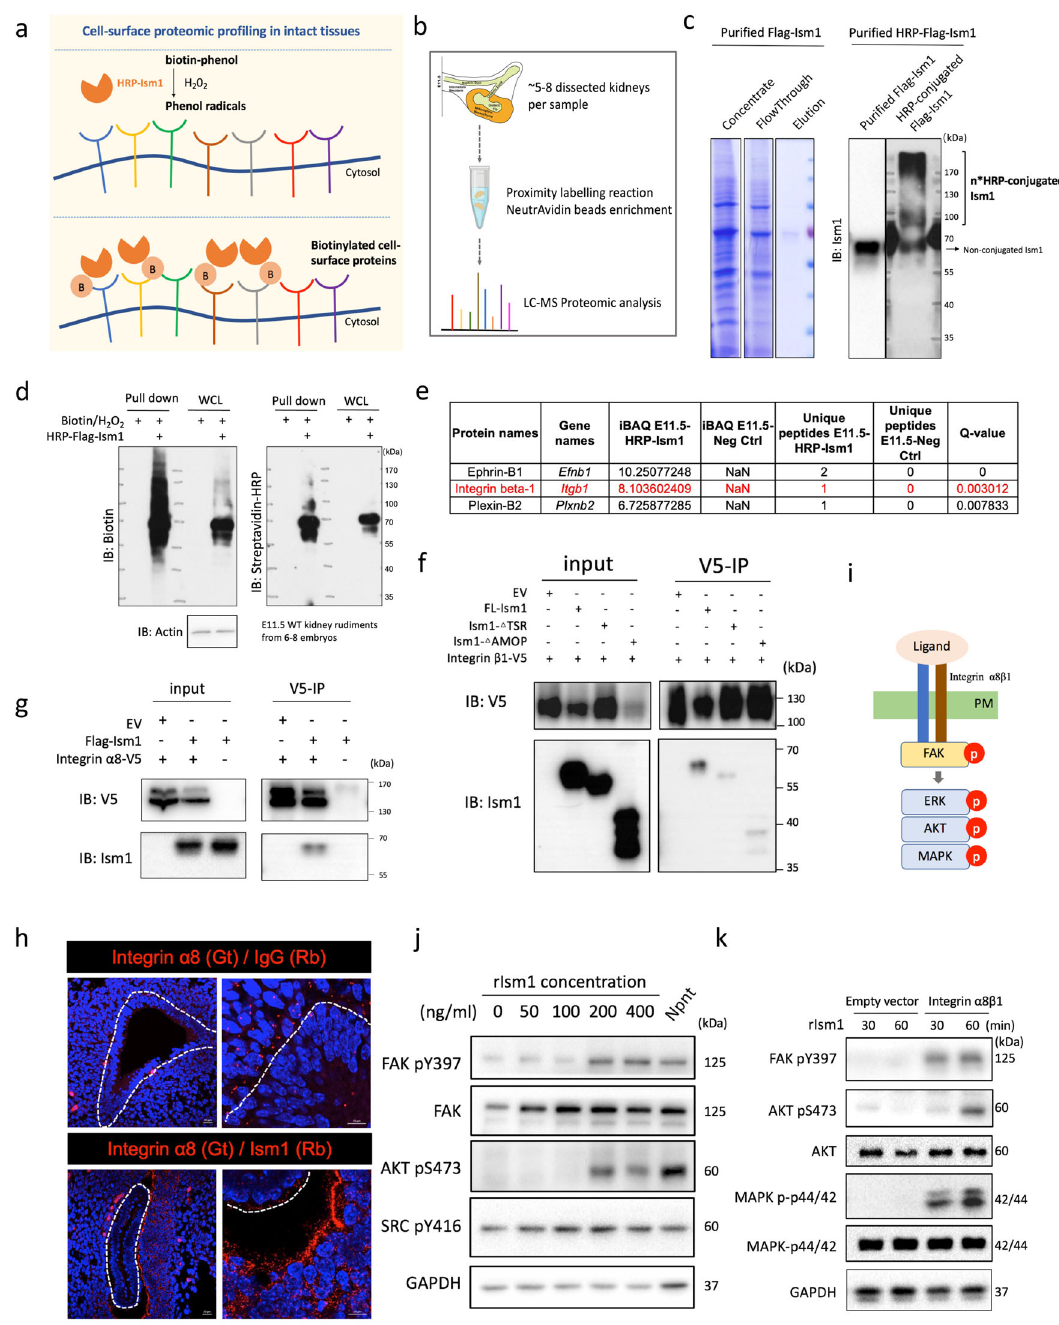
Fig. 6 | Ism1 enhances Gdnf/Ret signaling through a potent “ Integrin-like